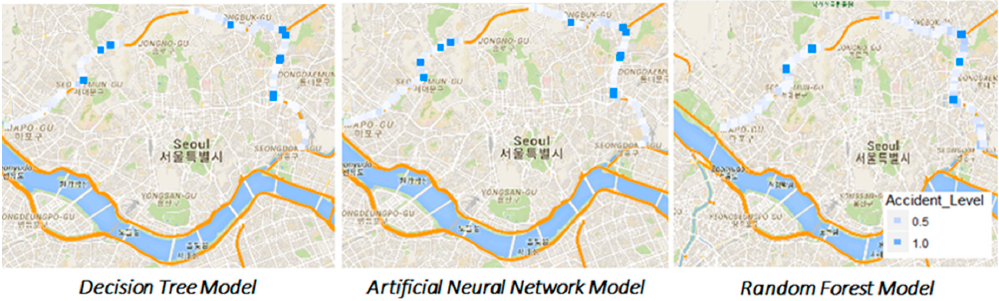
Figure 7. Examples of predicted AL values obtained from the three models.